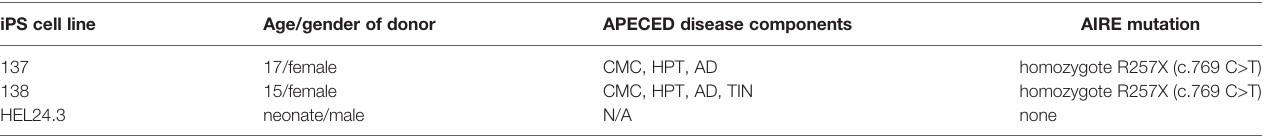
TABLE 1 | Relevant clinical and demographical information of the donors at time of blood/tissue donation for the generation iPSC. iPS cell